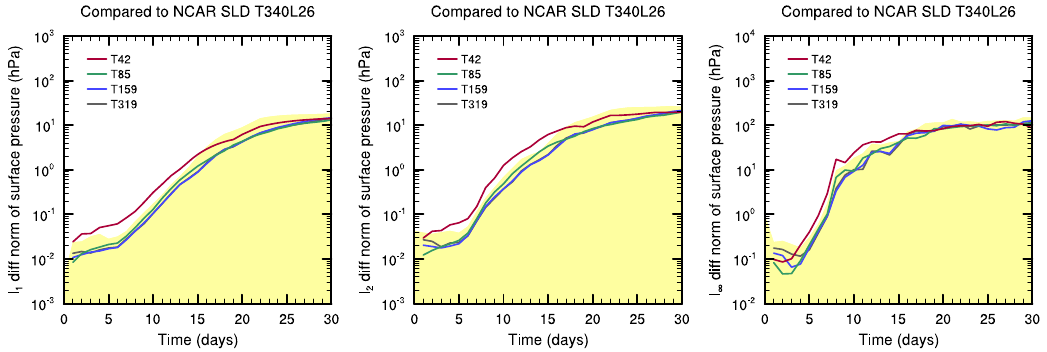
Fig. 10. As in Fig. 8 but between simulations performed with the spectral transform dynamical core of ECHAM and the reference solution at T340 provided by the NCAR semi-Lagrangian